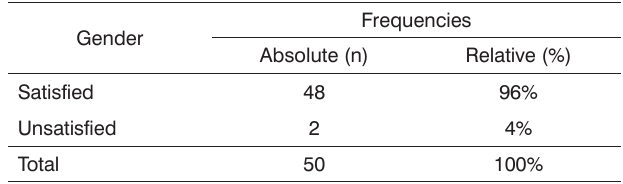
Table 1. Frequency distribution of reason-to-seek-treatment variable, in the total sample.